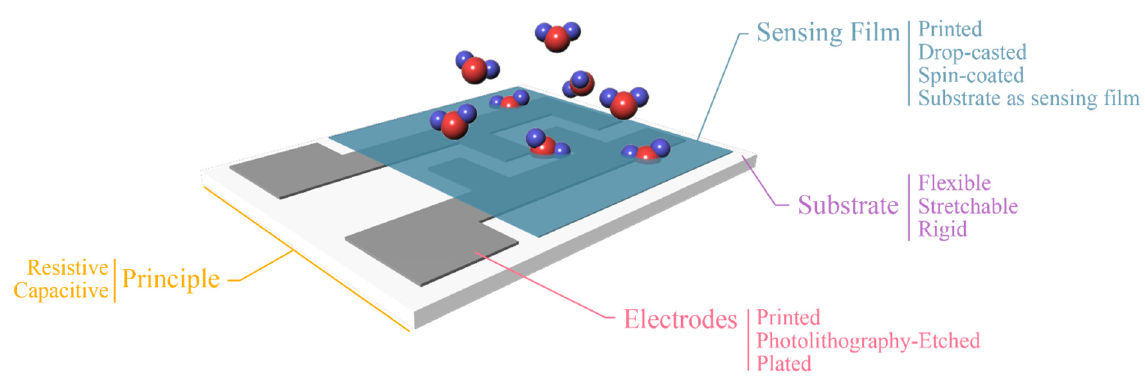
Figure 5. Various setups of partially of fully printed humidity sensors. Each category represents a subset of design con- siderations.